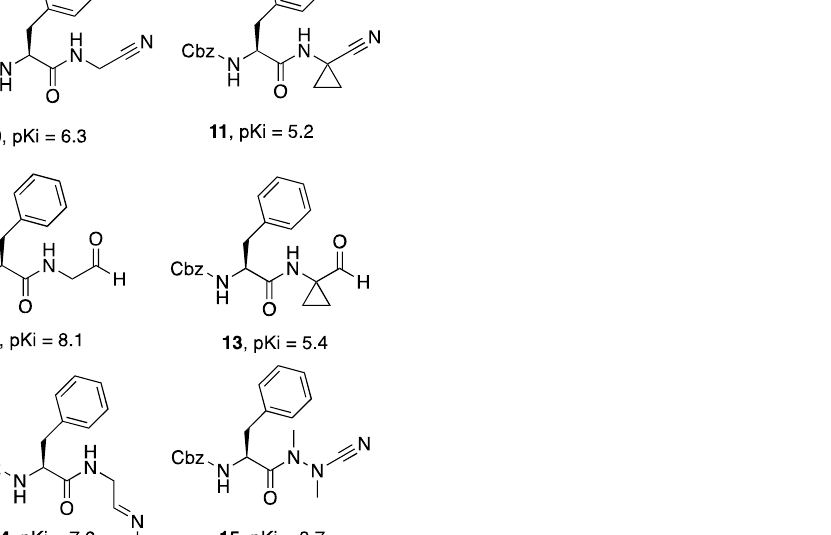
Figure 4. Exploration of different warheads in dipeptidic Cz inhibitors 10 – 15 .